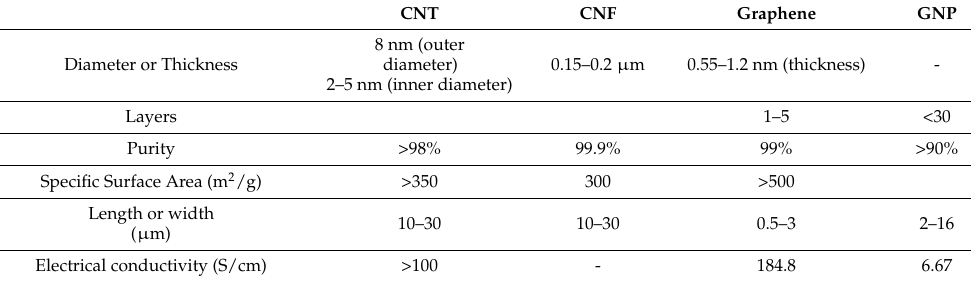
Table 1. Dimensions and physical properties of carbon nanomaterials.